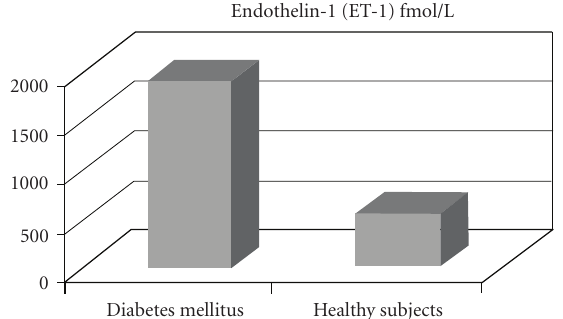
Figure 1: The plasma immunoreactive-endothelin concentrations were found to be greatly raised in the patients with diabetes (1,880 +/ − 120 fmol/l, mean +/ − SEM) compared with the healthy subjects (540 +/ − 50fmol/l, P less than .005). Figure adapted from Takahashi et al.